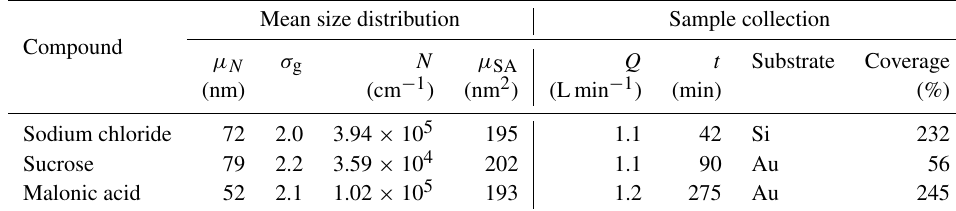
Table 1. Aerosol sampling data including generated size distribution information (geometric mean number µ N , geometric number standard deviation σ g , total number N and geometric mean surface area µ SA ) and sample collection parameters (sampler flow rate Q , collection time t , substrate and